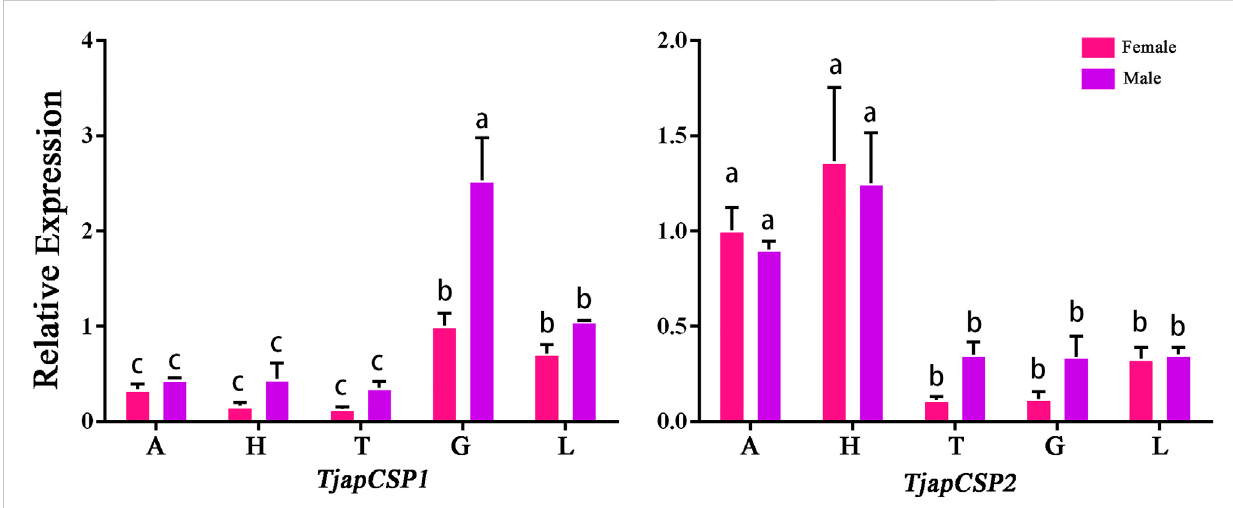
FIGURE 9 Expression pro fi les of T. japonensis CSPs in different tissues of female and male. A: antennae; H: heads (without antennae); T: thoraxes; G: external genitals; L: legs. The letters above the error bar denote signi fi cant differences ( p <